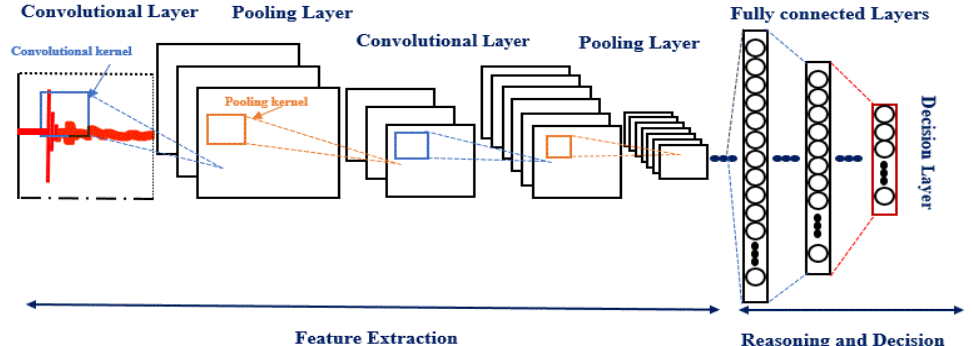
Figure 20. A convolutional neural network’s general structure.